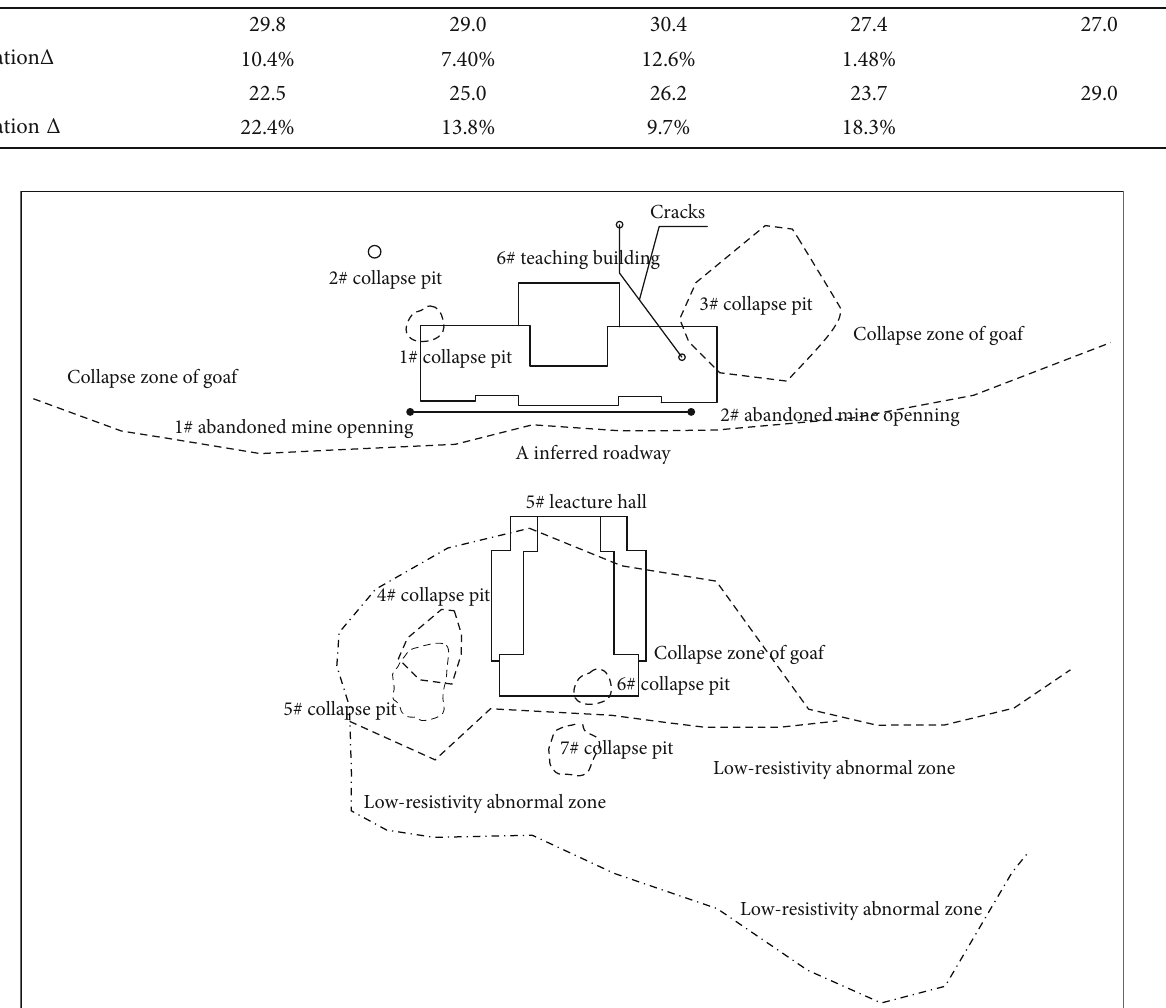
Figure 9: Location of goaf and distribution of collapse